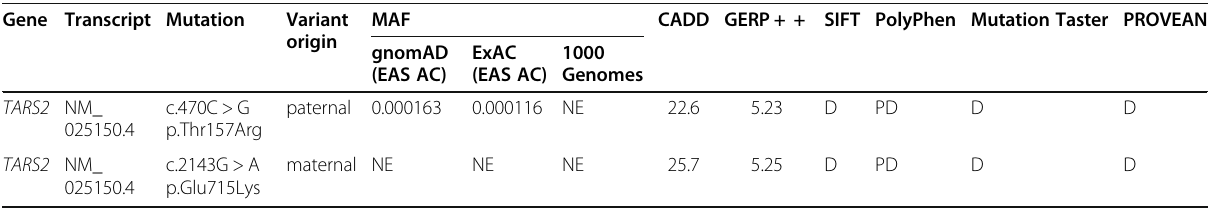
Table 1 The analysis of pathogenicity of the variants in TARS2 Gene Transcript